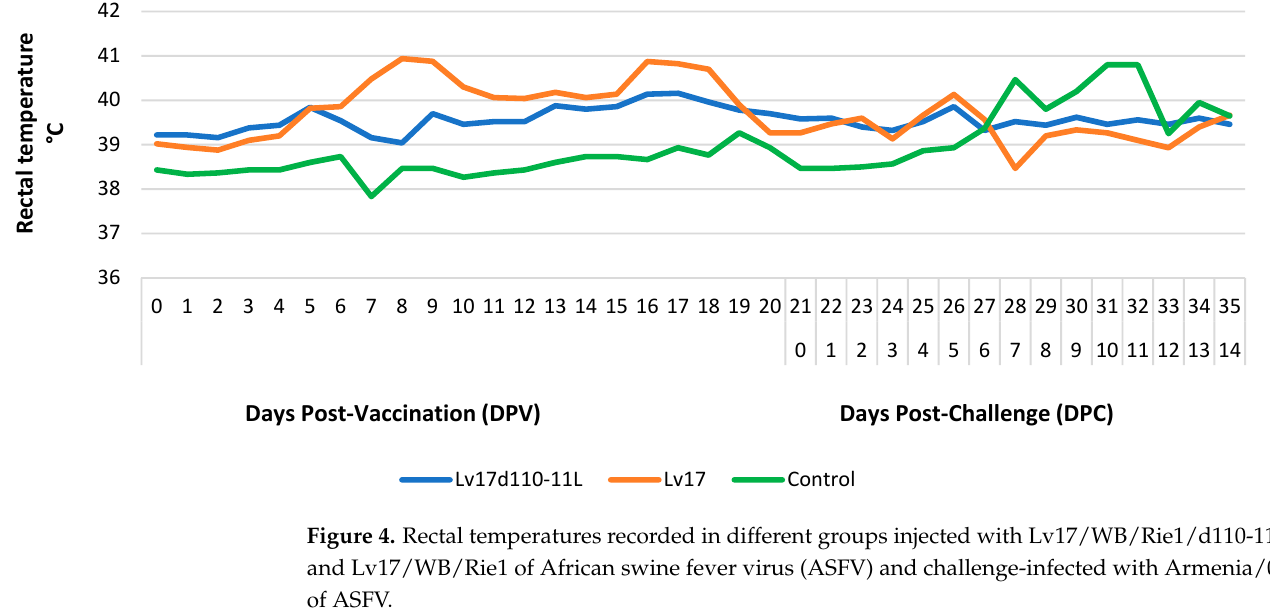
Figure 4. Rectal temperatures recorded in different groups injected with Lv17/WB/Rie1/d110-11L and Lv17/WB/Rie1 of African swine fever virus (ASFV) and challenge-infected with Armenia/07 of ASFV.